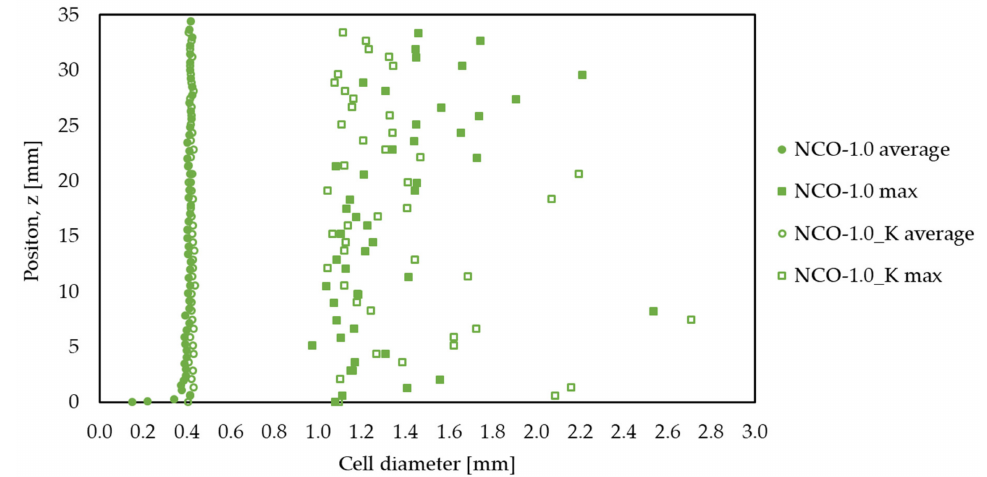
Figure 3. Average and maximum cell diameters along the sample height of the NCO-1.0 sample examined with a micro-CT before (NCO-1.0, filled circles and squares) and after (NCO-1.0_K, empty circles and squares) dry heat aging.